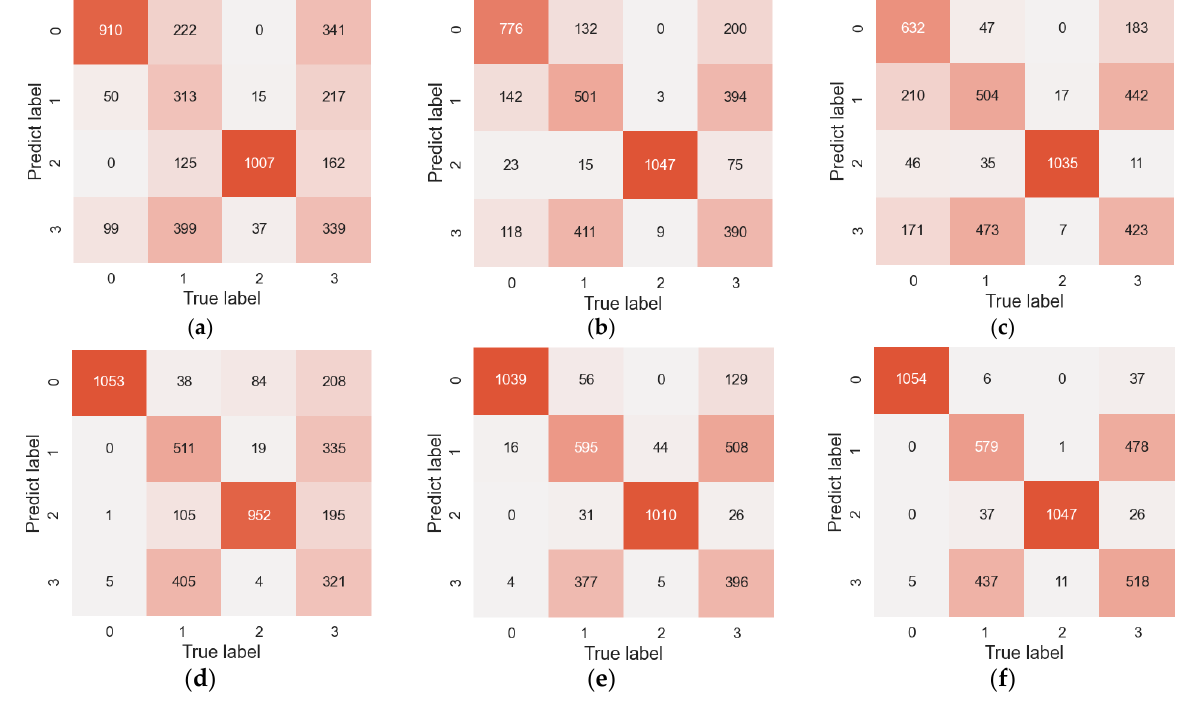
Figure 7. Confusion matrix of experiment 4. ( a ) SAE-SSL; ( b ) 𝜋 -Model; ( c ) DNN-SSL; ( d ) VAE-M1; ( e ) MRAE; ( f ) MRAE-AG.